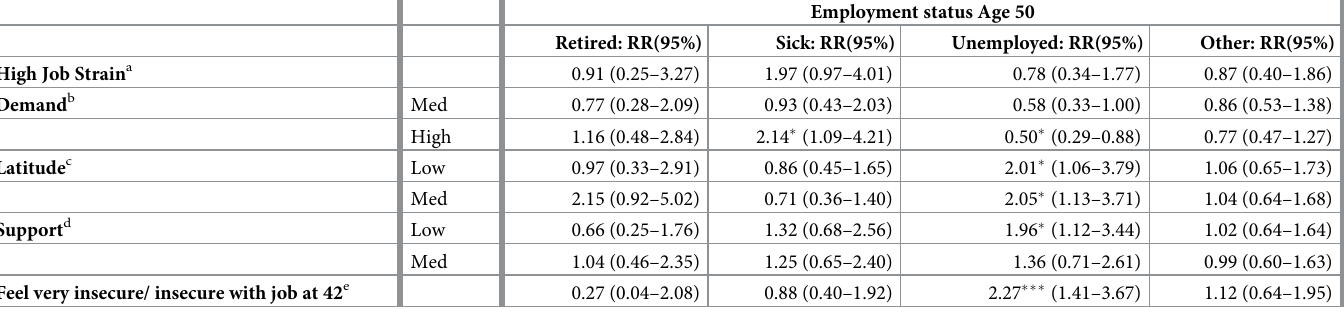
Table 3. Relative risks of work outcomes at age 50 for psychosocial work characteristics: Adjusted models on imputed data (sex, housing tenure, socioeconomic, marital status, education). Paid work is the reference